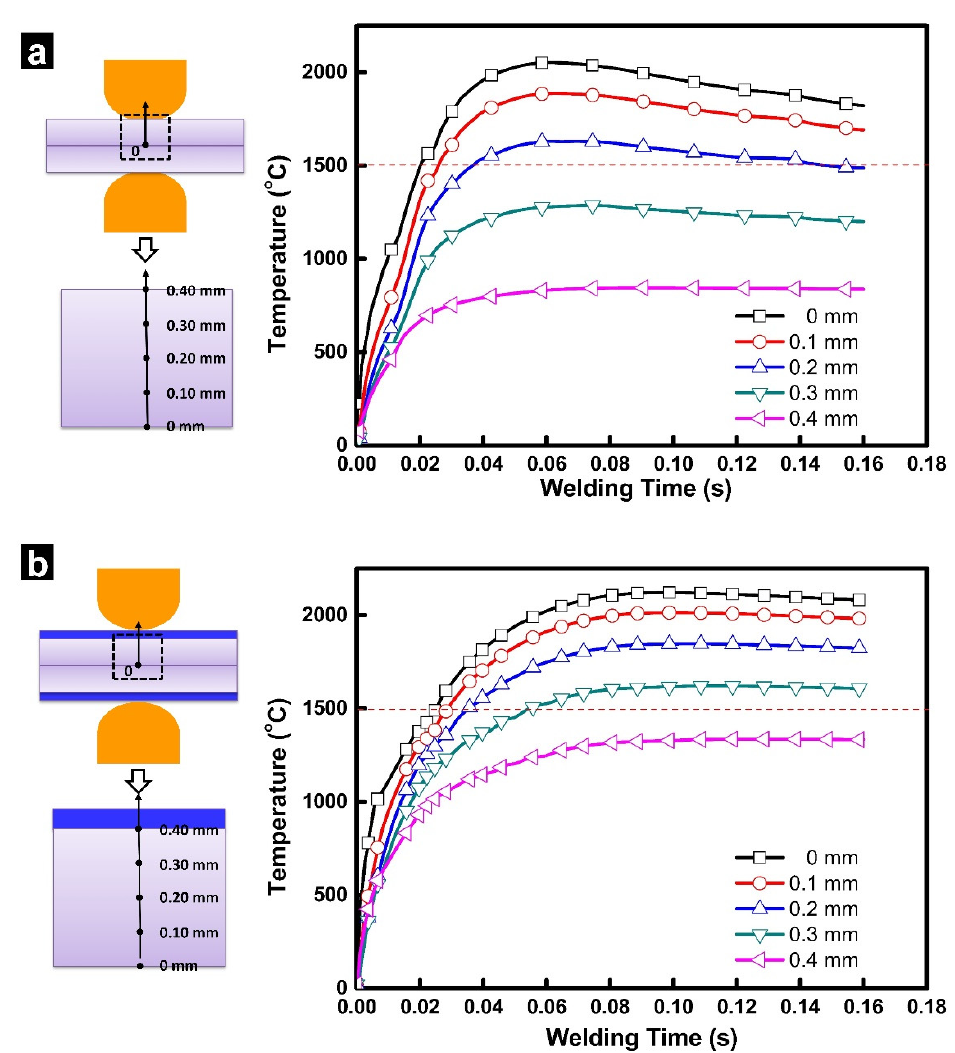
Figure 3. Calculated temperature histories in resistance spot welding of a 0.40 mm SAE1004 steel (results are presented for different levels of penetration in the steel sheet, ranging from 0 mm (faying interface) to 0.4 mm (electrode surface)), ( a ) without strip and ( b ) with a 0.10 mm AISI304 strip.